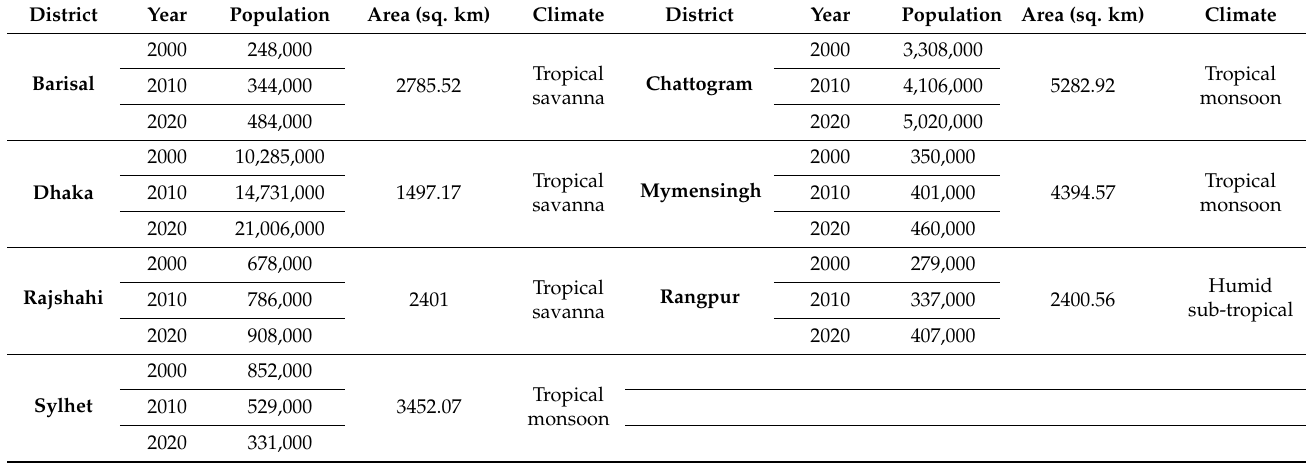
Table 1. Different characteristics of study area.